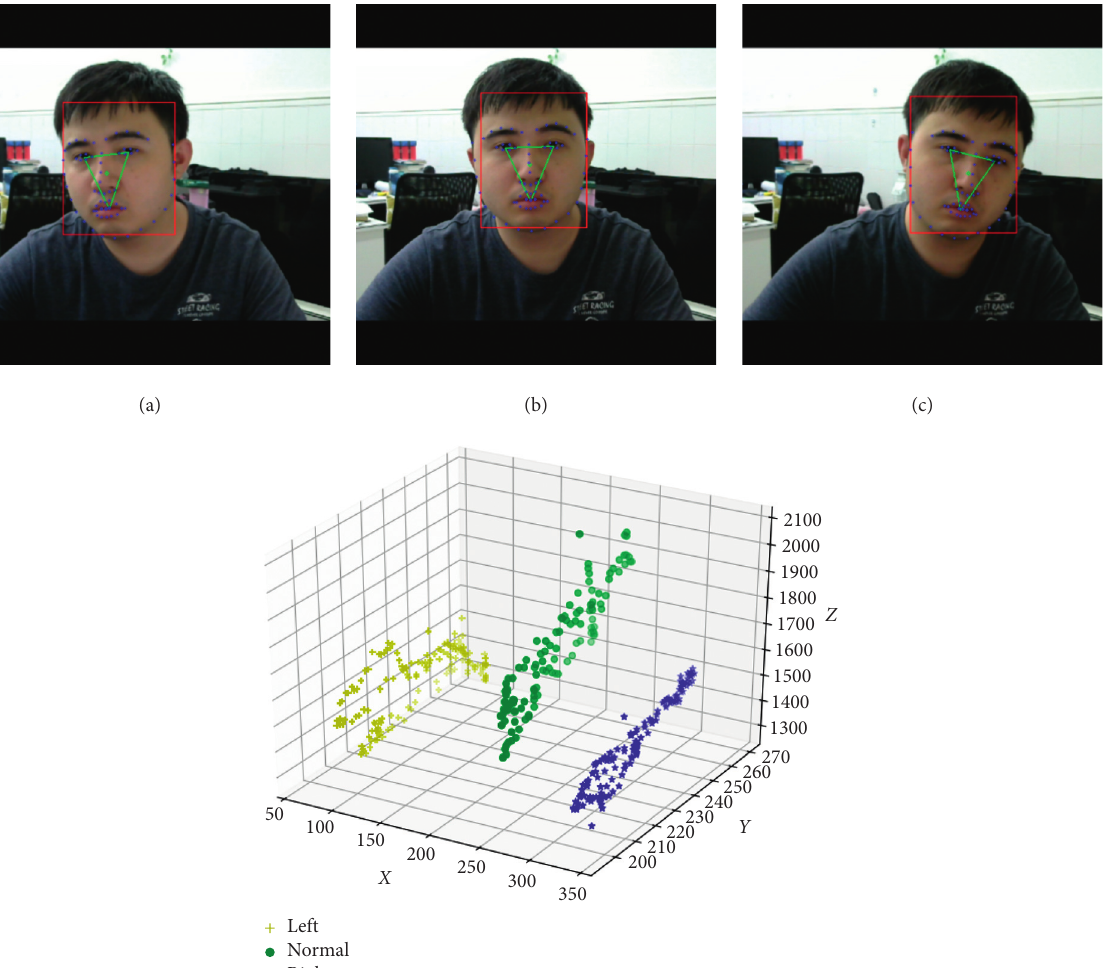
� √ F S . “Left” stands for the left swing of the face, x , Y is y , and Z is